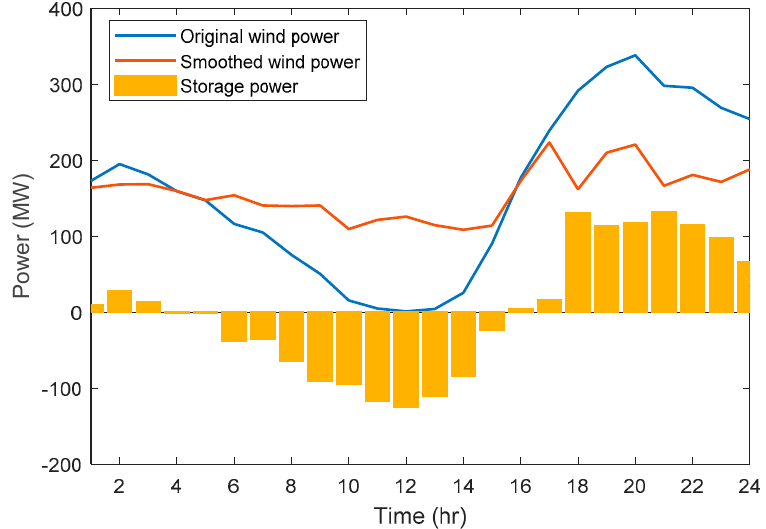
Figure 8. Advantage of storage in smoothing daily wind energy fluctuation.